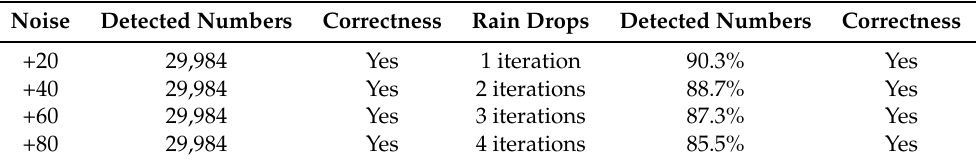
Table 8. Quality affected by noises, blurs, and raindrops.